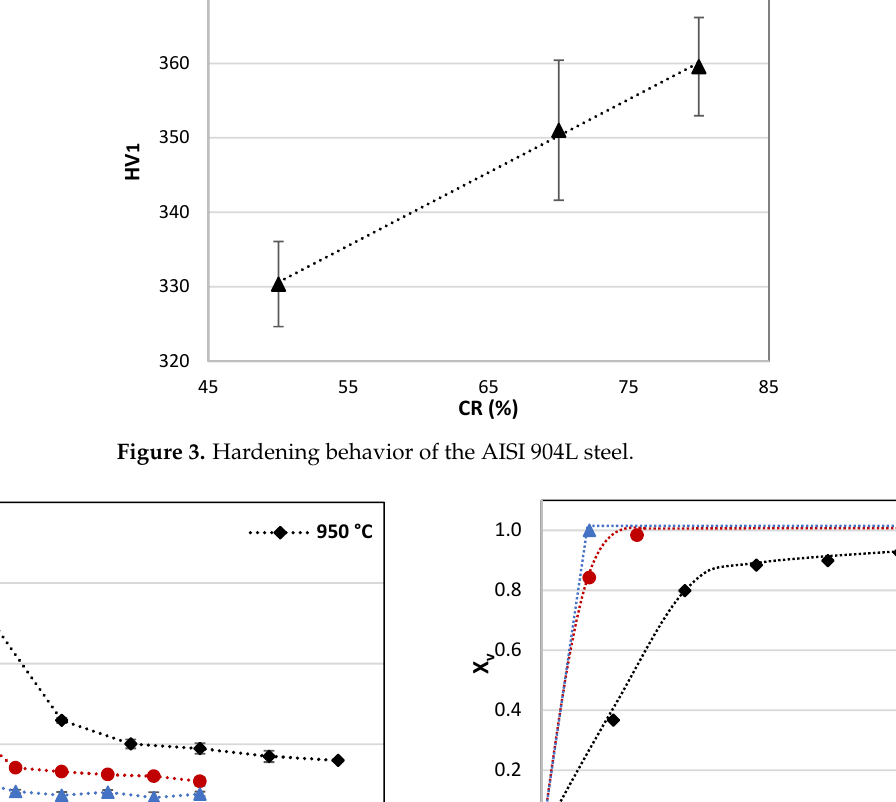
Figure 3. Hardening behavior of the AISI 904L steel.